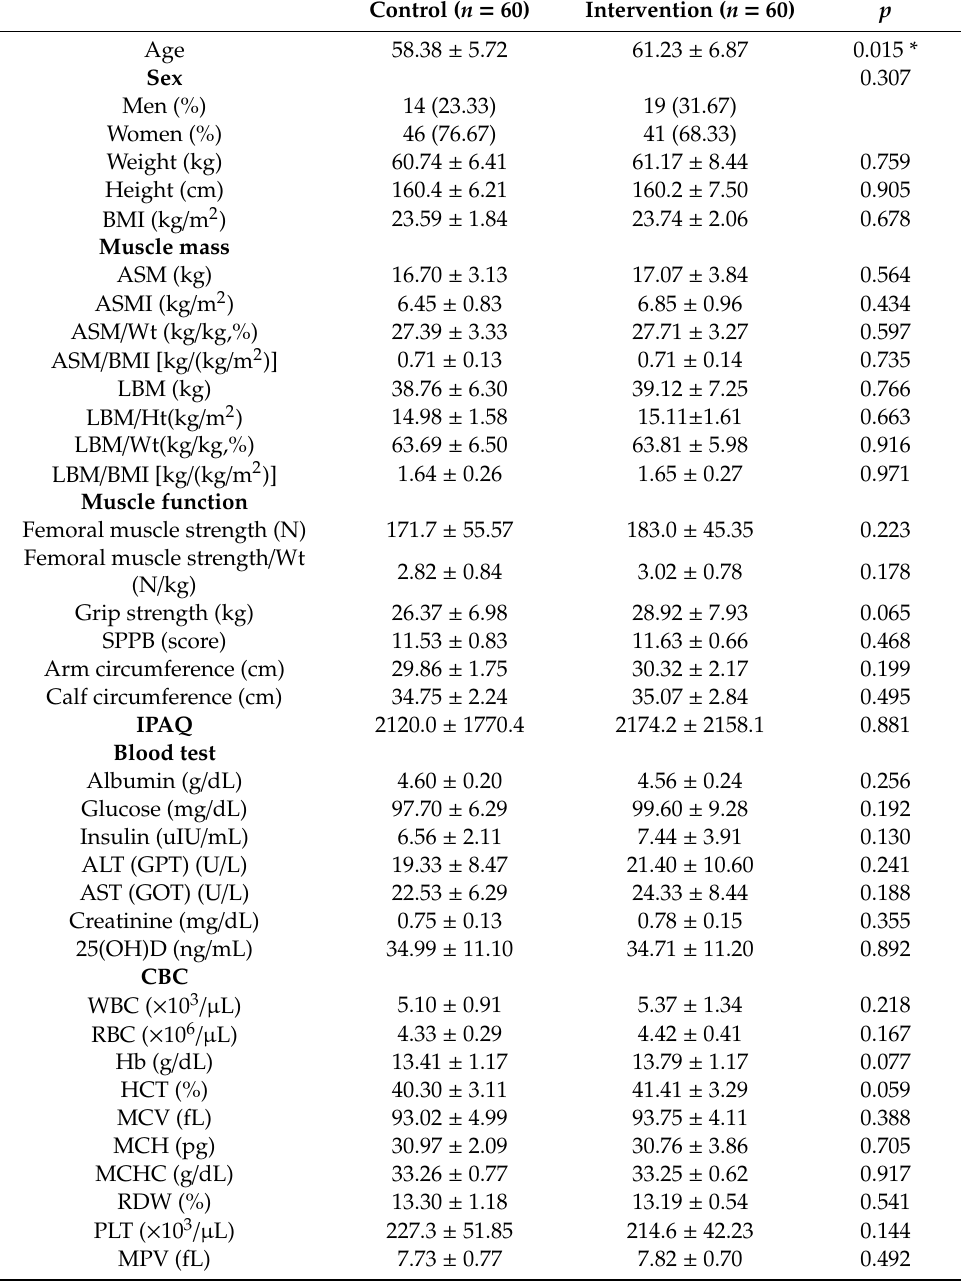
Table 1. Baseline characteristics of